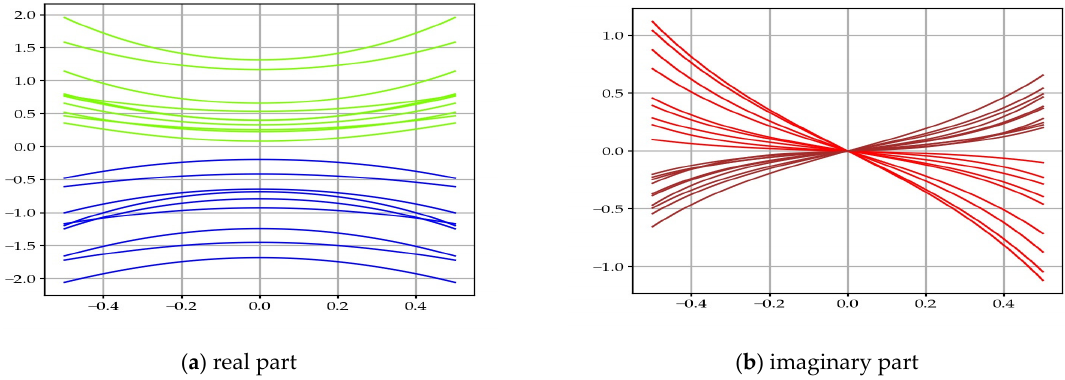
Figure 6. Drawings of several cross-sections of 𝐹(𝑠) , when 𝑠 is not a zero: ( a ) real; ( b ) imaginary. On these different cross-sections at constant 𝑦 of the 𝐹 function, we observe the two symmetries which are characteristic of the function. The imaginary part is equal to zero for 𝑥 = ½ , since they are cross-sections, not corresponding to non-trivial zeros. The colors are different depending on whether they are after a zero with an odd or an even index.